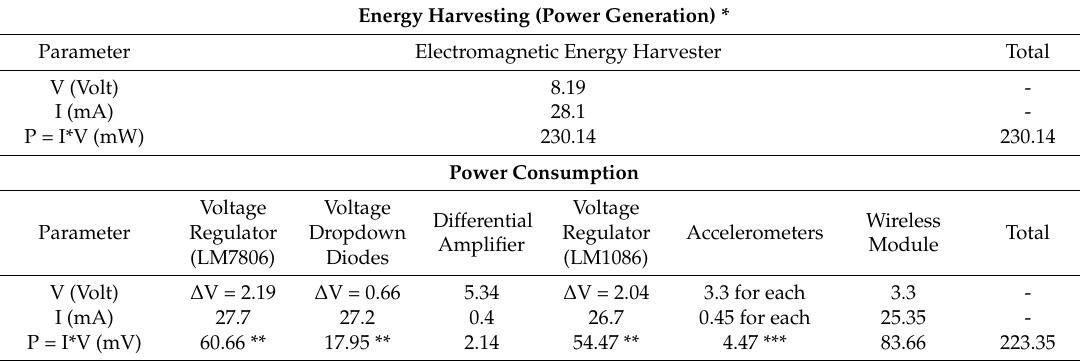
Table 1. The power-budget analysis of the